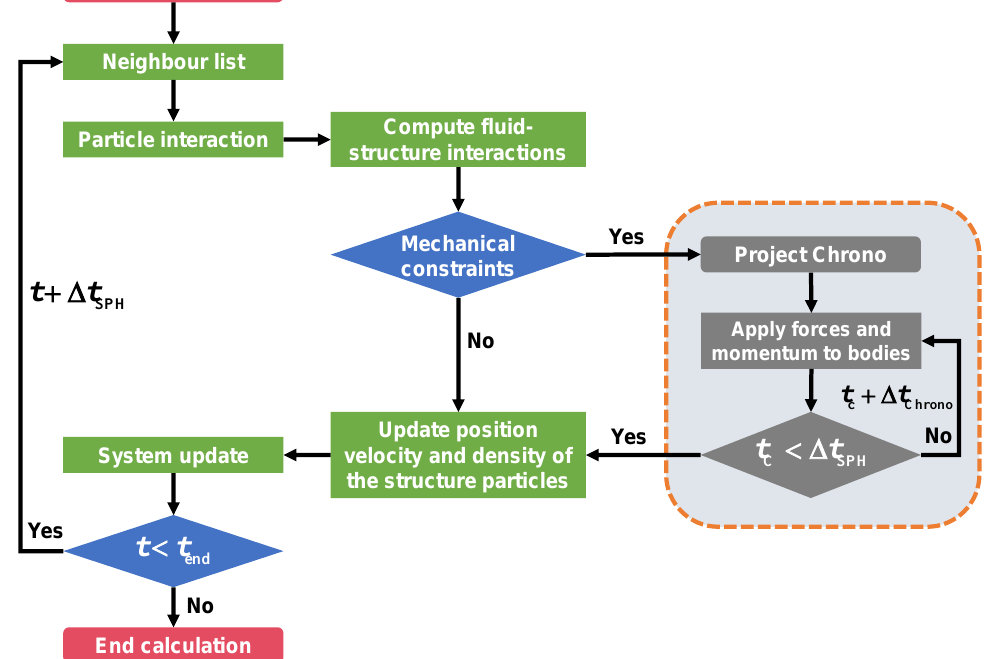
Figure 14. The flow chart of the coupling process between DualSPHysics and Project Chrono (adapted from